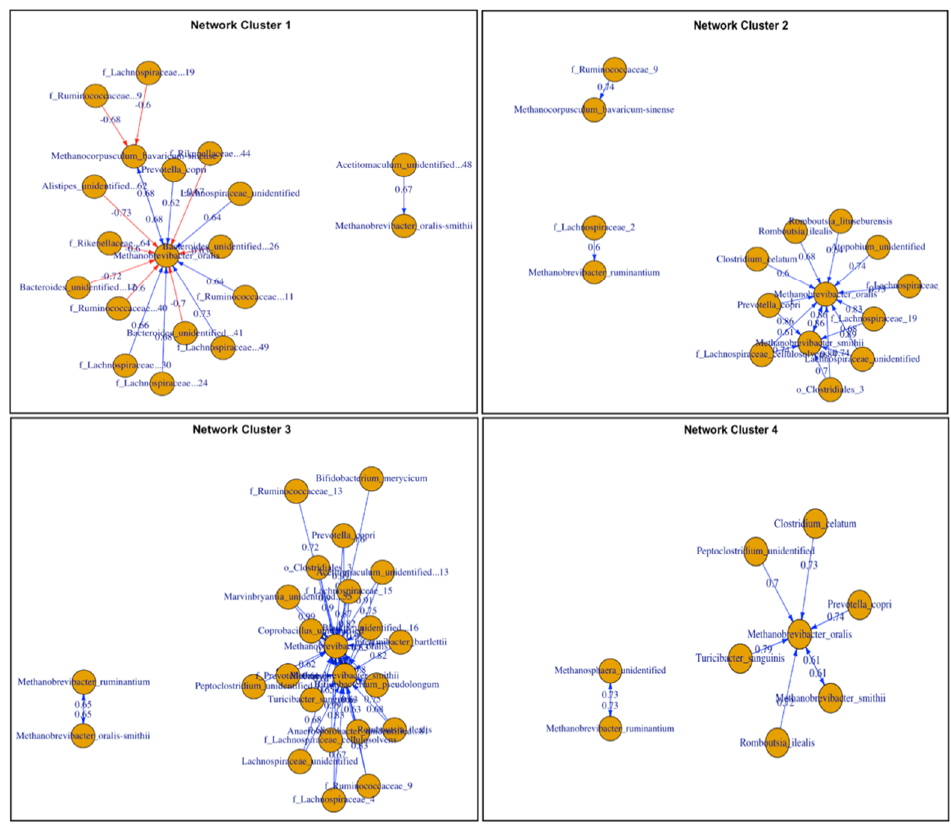
Figure 6. Co-occurrence network analysis based on Spearman correlation coefficients of bacterial species correlated with methanogens. The red color indicates a positive correlation and the blue color a negative correlation between the methanogens and the other bacterial species. ASVs were selected based on p -values ( p < 0.05) at a 60% level of correlation with methanogens. Edge weight values are shown for each link between methanogens and bacteria.